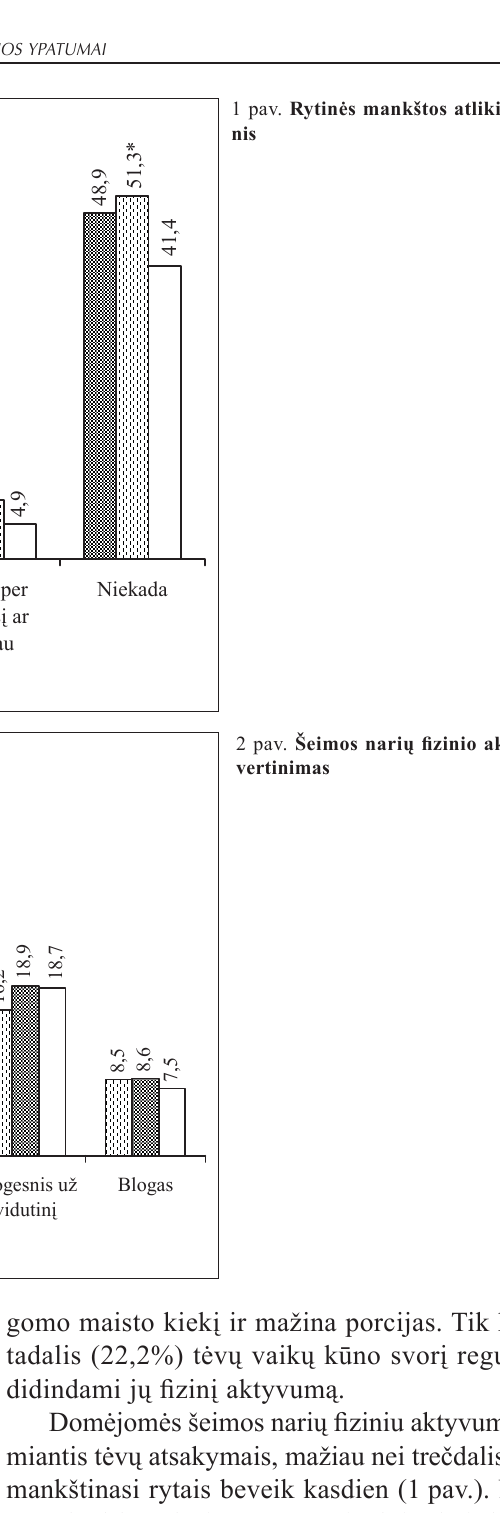
dažnio ir t ėč io išsilavinimo pastebima